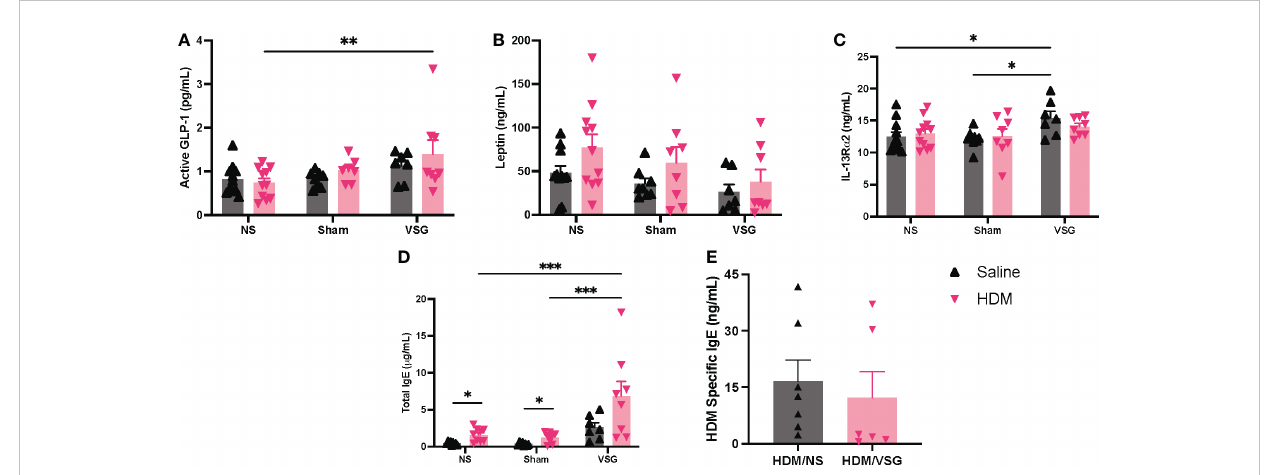
FIGURE 8 Measurement of cytokines and total and HDM-speci fi c IgE in mouse serum. (A – E) Serum concentrations of (A) Active GLP-1, (B) Leptin, (C) IL- 13R a 2, (D) Total IgE, and (E) HDM Speci fi c IgE, n=6-11 mice per group. Grey bars and ▲ = saline-challenged mice; pink bars and ▼ = HDM- challenged mice. (A – D) were analyzed using a Two-way ANOVA with a Tukey and Sidak post-hoc test. (E) were analyzed using a non-parametric t- test *p<0.05, **p<0.01,